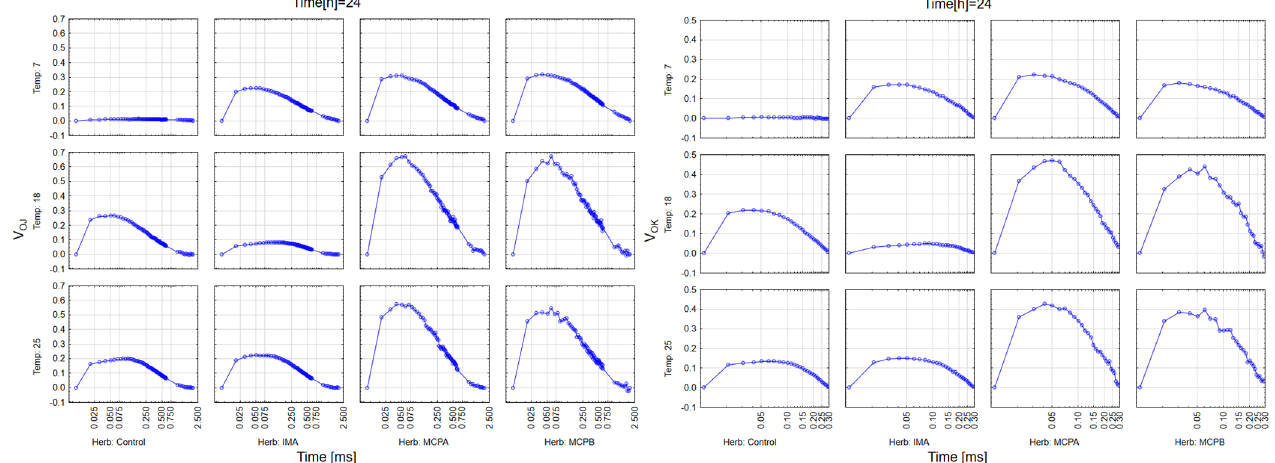
Figure 9. K-band (V OJ , left panel ) and L-band (V OK , right panel ) plots for G. orientalis plants exposed for 24 h to MCPA, MCPB and IMA. Data are means of five replicates.